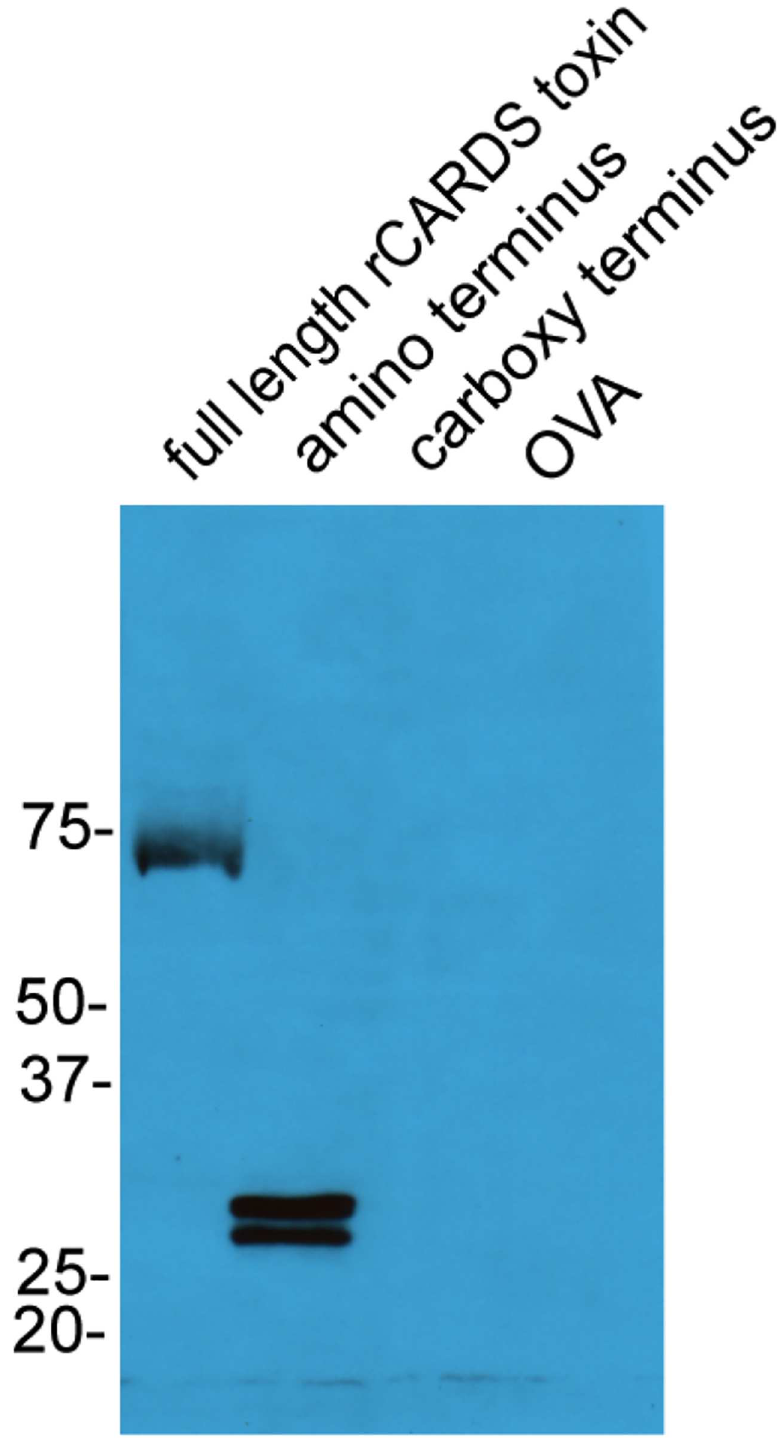
Fig 5. IgE from mice exposed to CARDStoxin recognizes full-length and N-terminal peptides of CARDStoxin on immunoblots. Serum collected from mice 56 days after exposure to CARDS toxin was pooledand used to probe immunoblots containingfull-lengthCARDS toxin, the N-terminal 1–249 amino acid peptide, the amino acid 269–591C-terminal peptide, and ovalbumin. Immunoreactive peptides were detected using an anti-mouse IgE